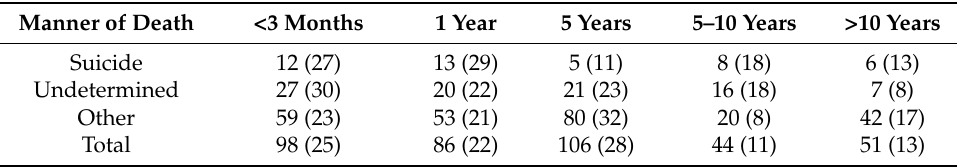
Table 2. Time since last contact with the clinic by manner of